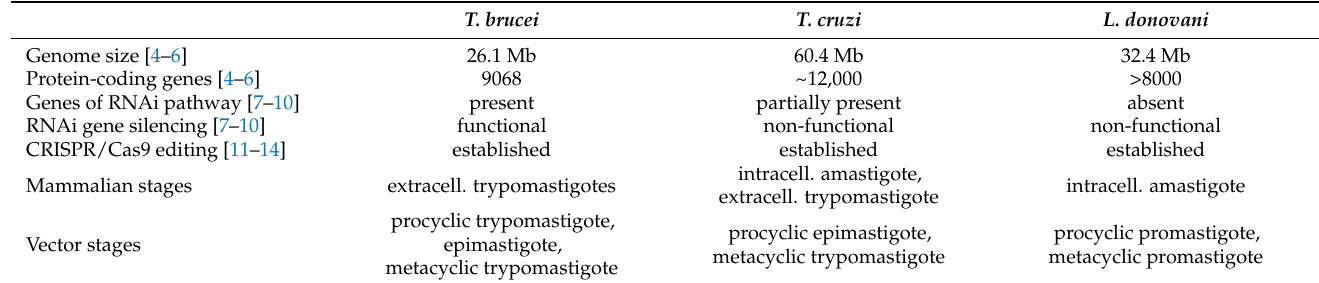
Table 1. Molecular and cellular characteristics of the three selected trypanosomatids.